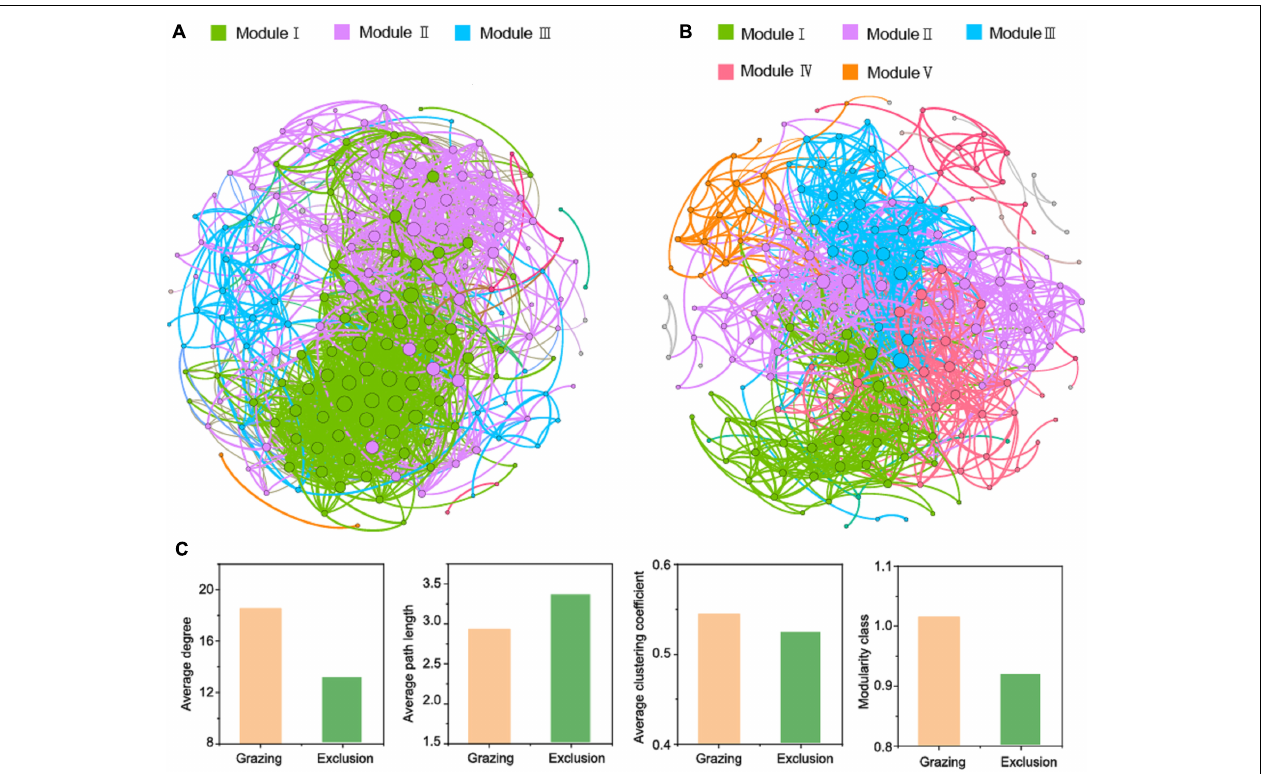
FIGURE 4 | Network analysis depicts the co-occurrence patterns among bacterial community based on operational taxonomic unit (Pearson’s R > 0.8, P < 0.05) for grazing (A) and exclusion (B) treatments as well as the topological indexes (C) . The node size indicates connectivity degree. The colors of the nodes and edges are grouped by modularity class. Different colors refer to different modules.